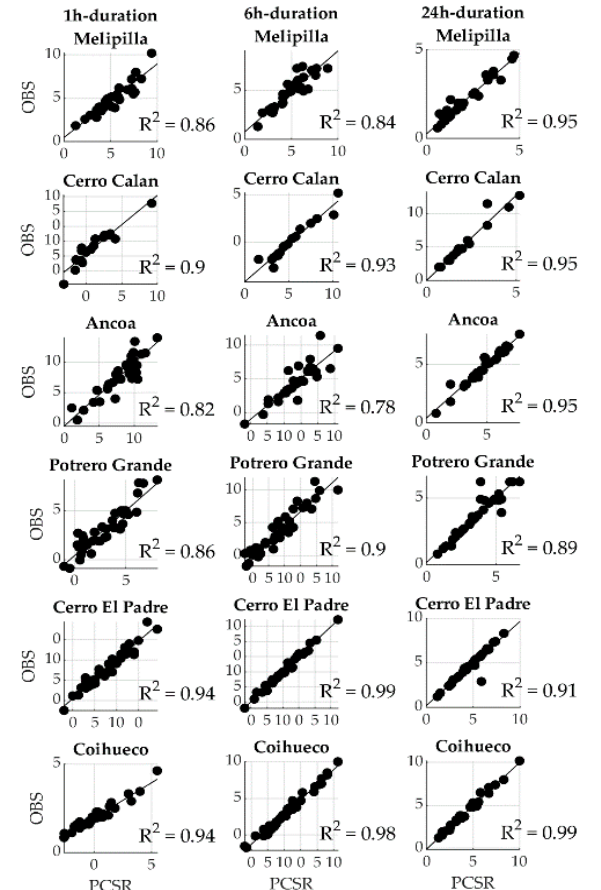
Figure 11. Scatter plots showing manual (observed) versus digital PSCR readings for different durations (1, 6, and 24 h). The rows represent different pluviograph gauges, and the columns represent storm durations of 1h, 6h, and 24h.